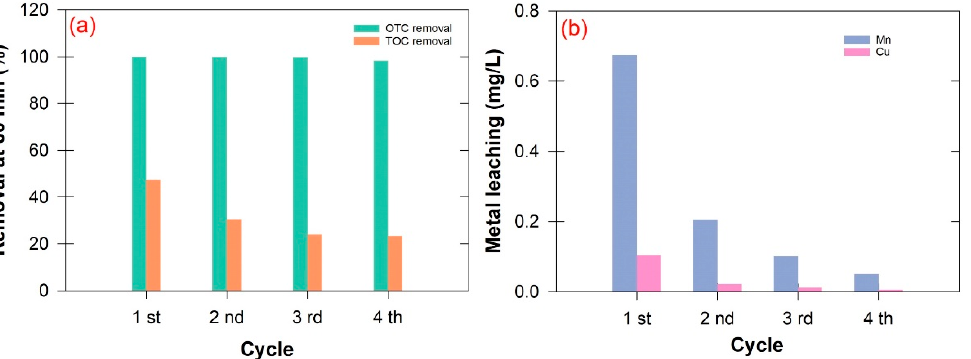
Figure 6. ( a ) OTC and TOC removal efficiency cycling test using the Cu 0.5 Mn 0.5 Fe 2 O 4 /H 2 O 2 /light system, ( b ) metal leaching concentration. (Conditions for each cycle: [OTC] 0 = 0.1 mM, [H 2 O 2 ] = 97.89 mM, catalyst loading = 0.5 g/L).